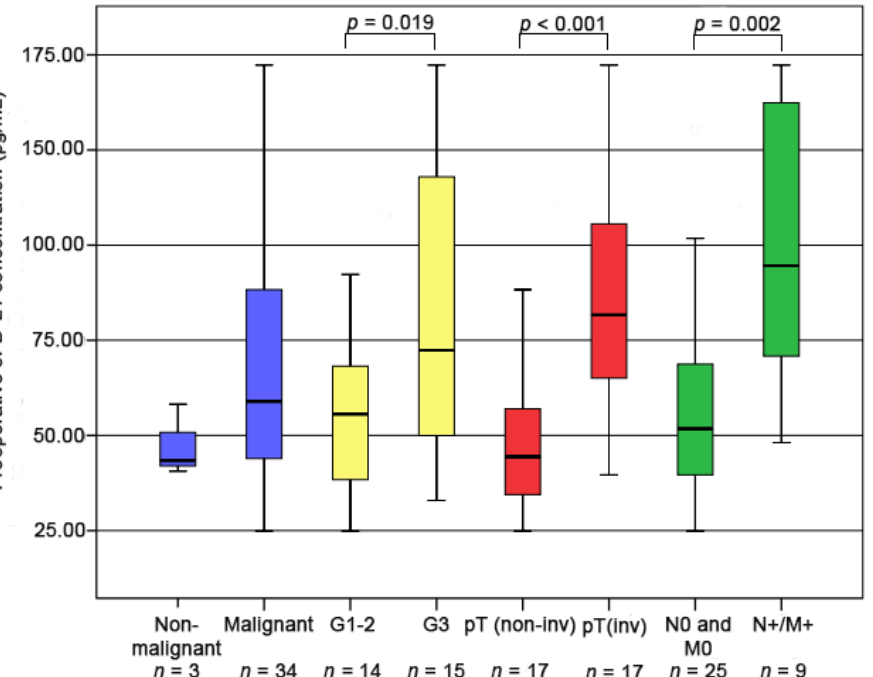
Figure 1. Association of preoperative sPD-L1 concentrations and clinicopathological parameters in the RNU cohort. pT(non-inv): pTa-pT1, pT(inv): pT2–pT4. For the CTX cohort, similar to the findings in the RNU cohort, baseline sPD-L1 levels were higher in metastatic cases ( p < 0.001) (Table 1). Furthermore, patients who received gemcitabine/carboplatin instead of gemcitabine/cisplatin had significantly elevated sPD- L1 levels ( p = 0.013). As low case numbers of the ICI cohort did not allow the performance of a valid statistical evaluation, we provided patients’ characteristics on an individual patient level in Table